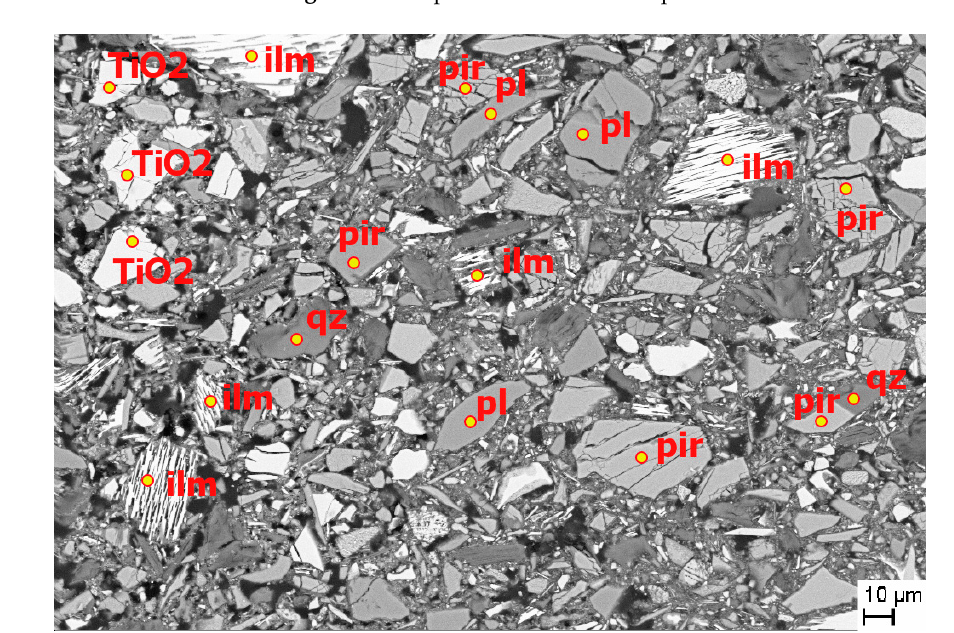
Figure 3. Backscattered electron (BSE) image of R ‐ MUD sample (backscattered electron mode).